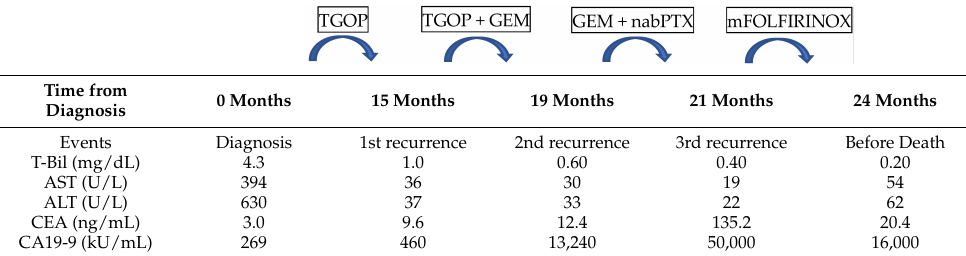
Table 1. Laboratory data of patients at different stages of